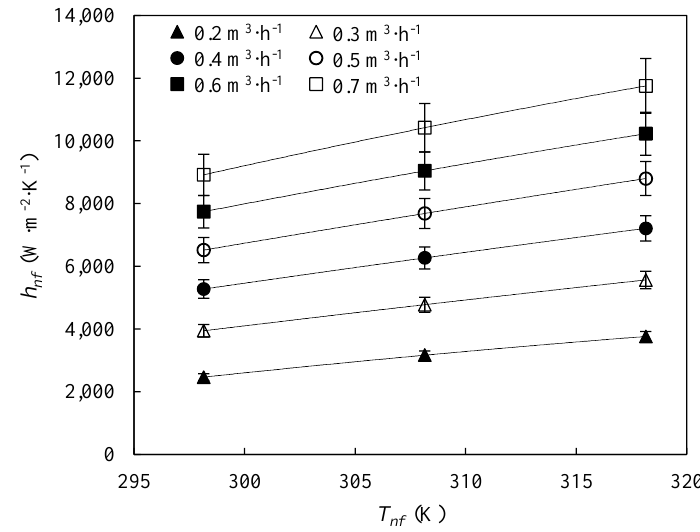
Figure 5. Temperature, T nf , dependence of convection heat transfer coefficients of 0.25 wt % nanofluid, h nf , for different volumetric flow rates. Error bars indicate the expanded uncertainty ( k = 2).